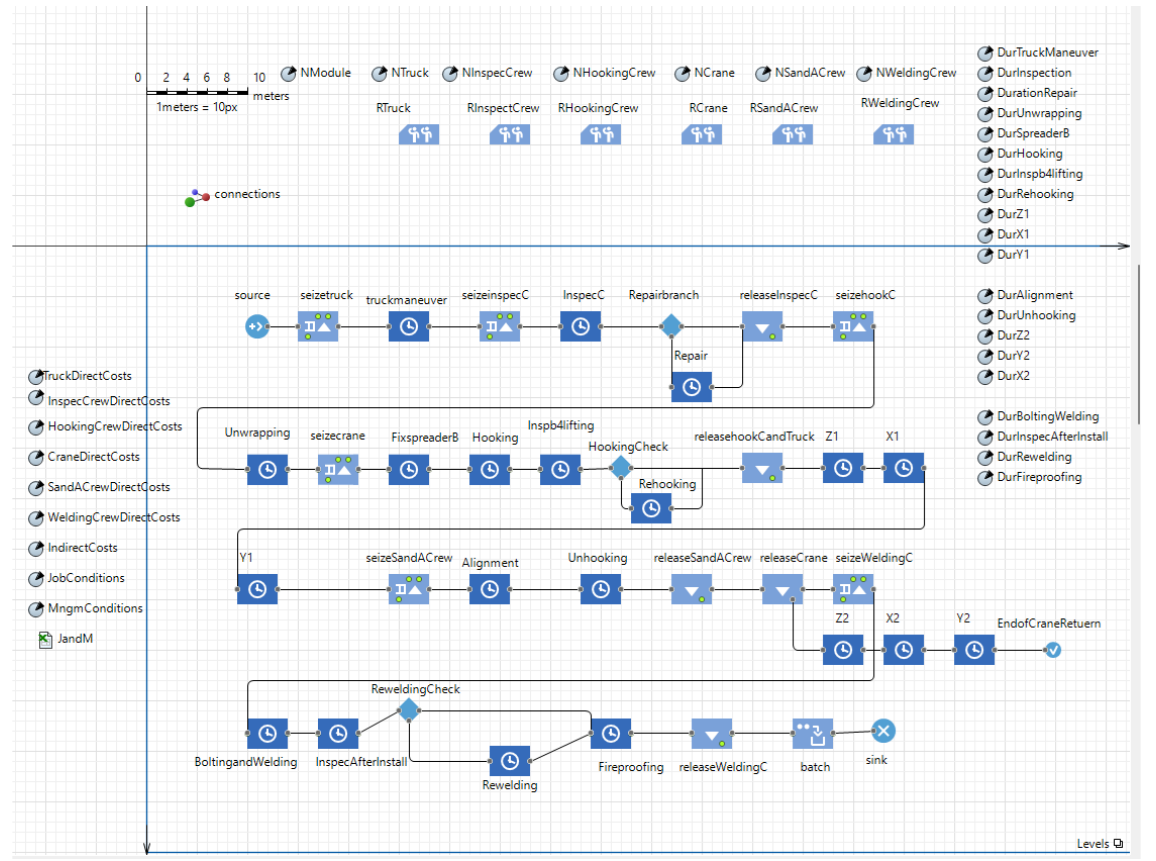
Figure 5. DES model of MiC installation in AnyLogic environment .